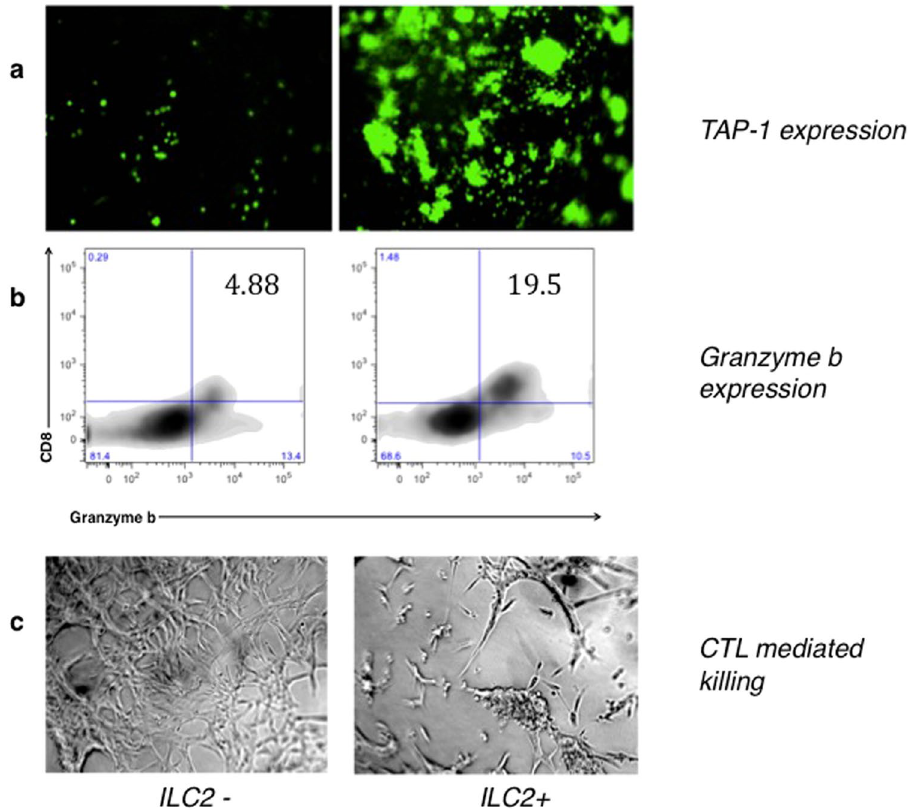
Figure 7. Impact of ILC2s on specific CTL effector mechanisms. Co-culture of metastatic murine prostate TAP-1-low carcinoma cells (LMD) and CD8 T cells with ILC2s (right panel) or without ILC2 cells (left panel): ( a ) TAP-1 expression level in LMD cells after activation with ILC2 cells (right) and without ILC2 cells (left); ( b ) Granzyme b expression by CTL cells in the absence of ILC2s (left) or in the presence of ILC2s (right); ( c ) Light microscope images of cell co-cultures after the incubation with CTLs show the extent of CTL-mediated killing, either in the presence or absence of